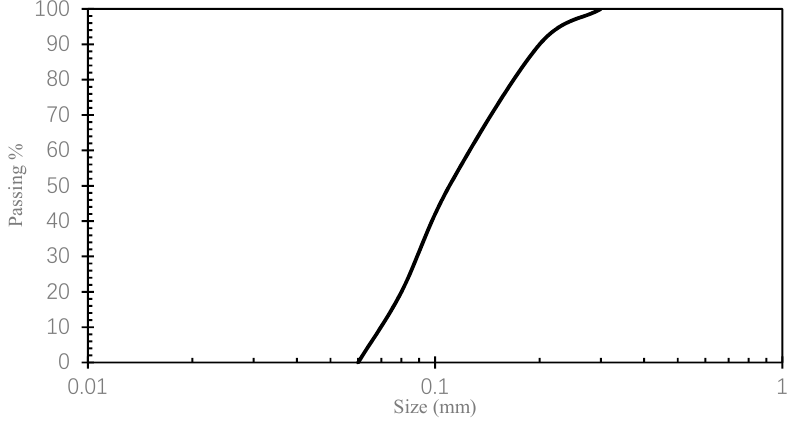
Figure 5. Particle size distribution of the Congleton sand.